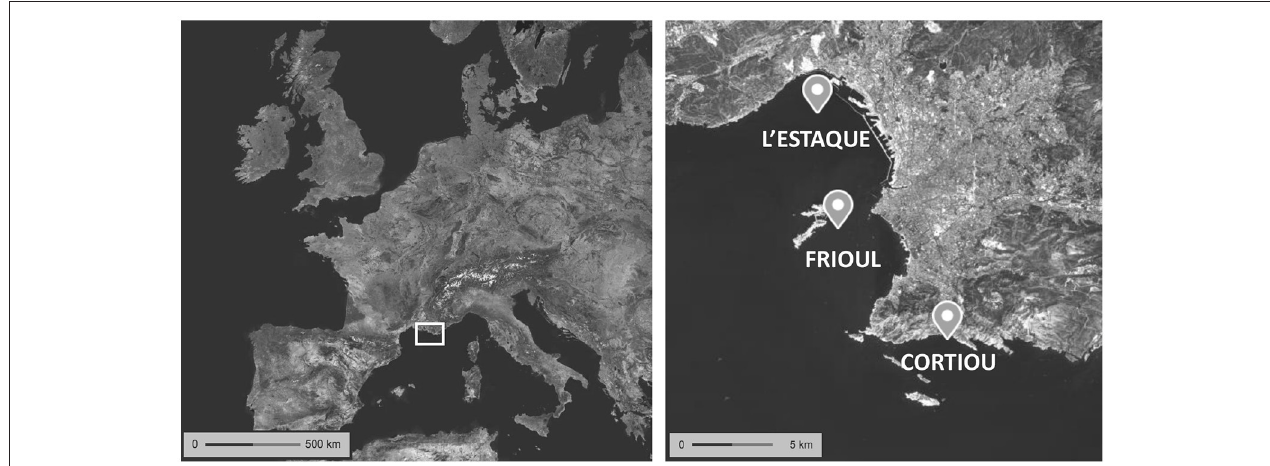
FIGURE 1 | Sampling locations in Marseille Bay. Map from the French National Institute of Geographic and Forestry Information.